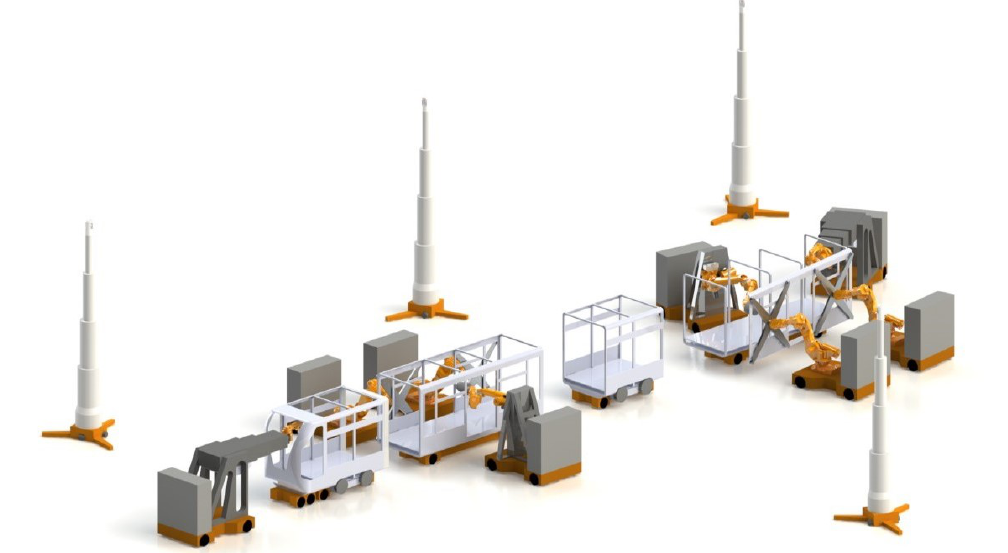
Figure 3. An illustration of DT in manufacturing: line-less mobile assembly system [85]. © WZL— RWTH Aachen. Table 1. Summary of AI-enabled DTs in smart manufacturing: factory and shop floor level (Section 2.2).